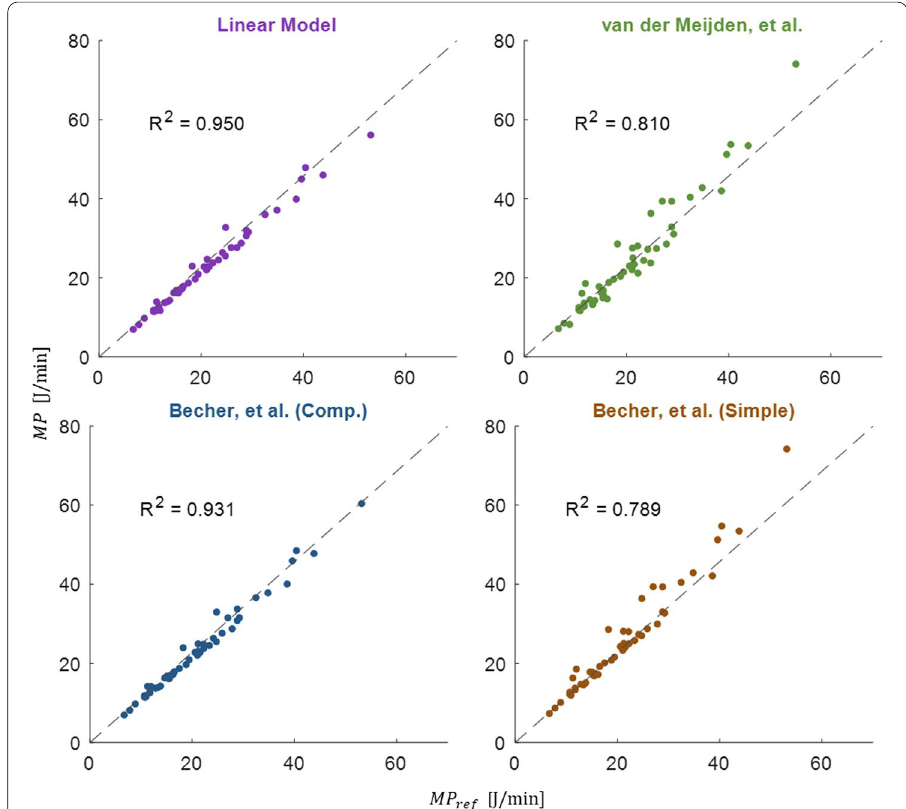
Fig. 2 Agreement between each of the four mechanical power equations ( y -axis) and the numerically integrated value (MP ref ) ( x -axis). Dashed line represents 1:1